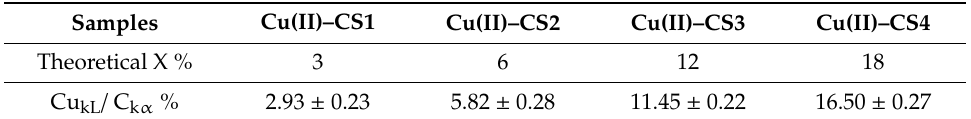
Table 2. Calculated amount of Cu in the coatings by using energy-dispersive X-ray (EDX).